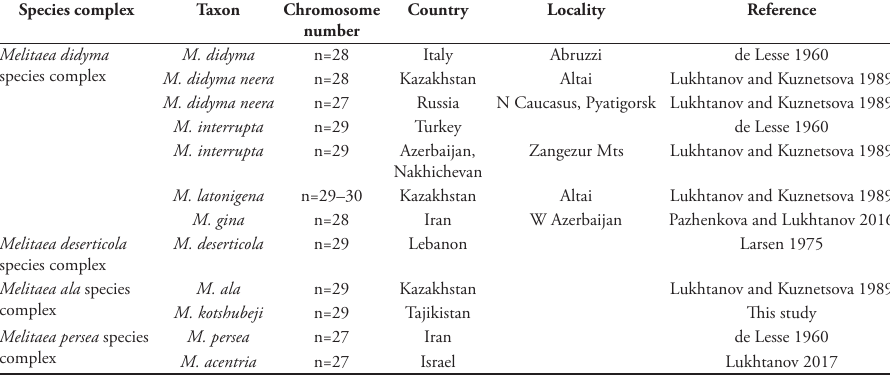
Country Locality Reference number